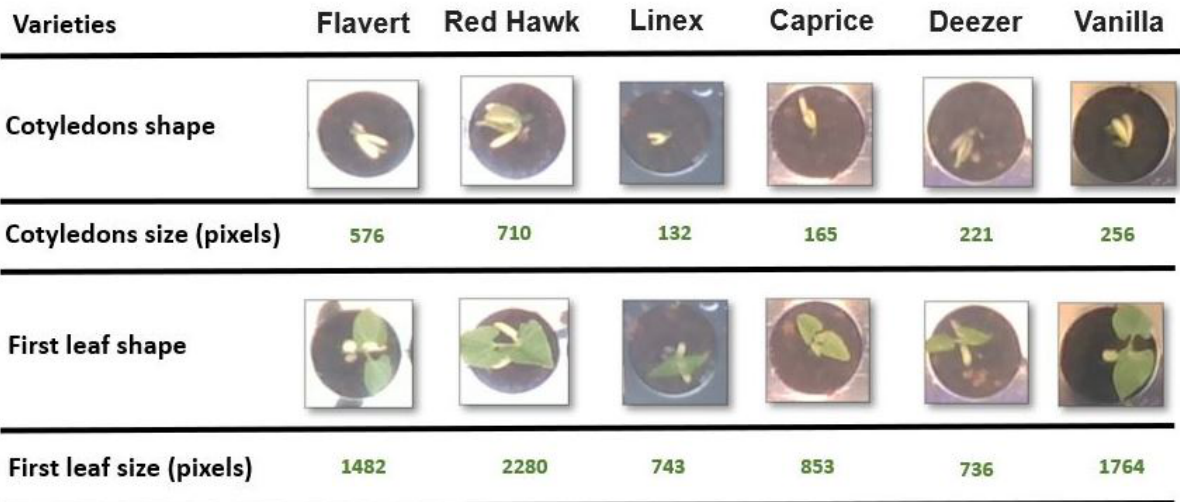
Figure 10. Heterogeneity of shape and size in the two events OC and FL for the different bean varieties used in the